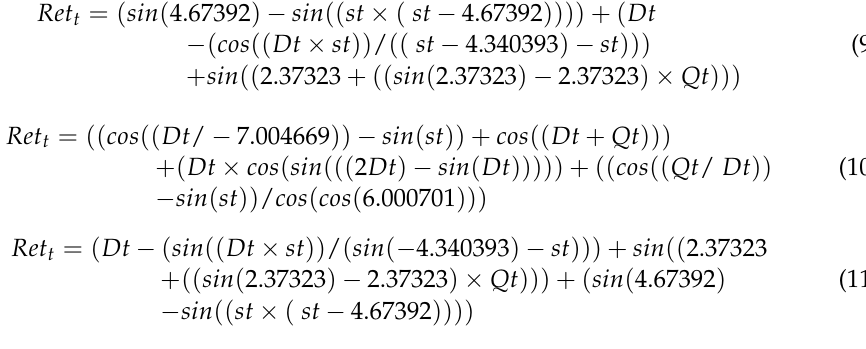
Table 5. The values of the objective functions examined in three